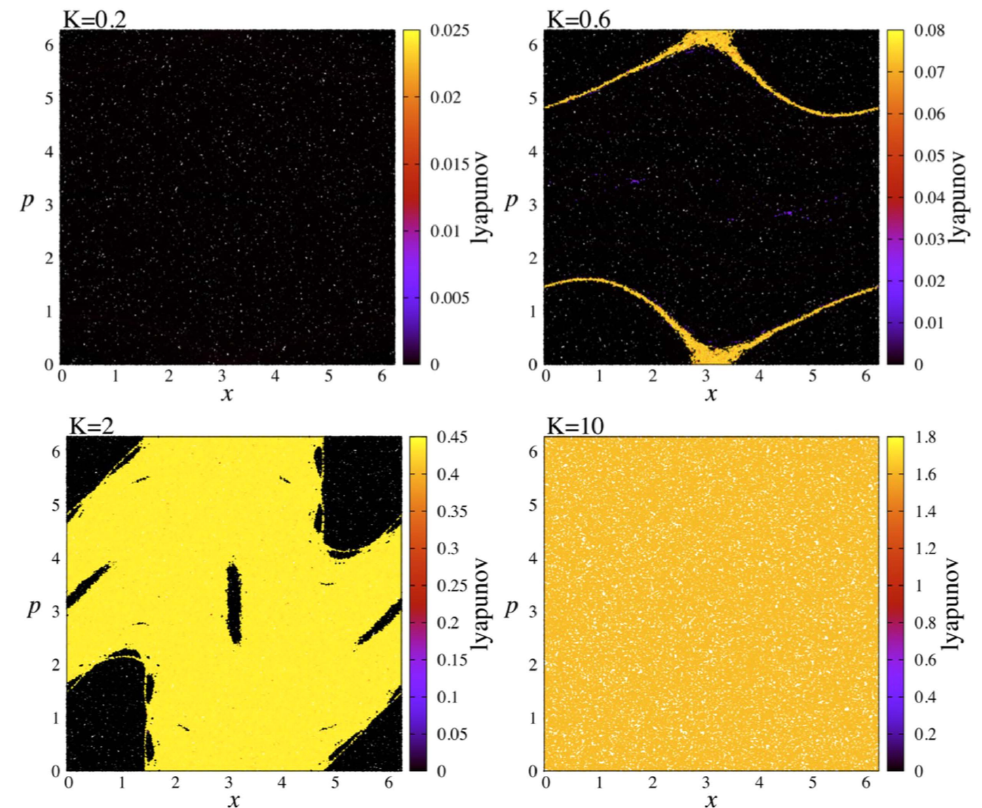
Figure 9. Lyapunov exponent results of the phase portrait of the standard map. The same repre- sentative K values are used. For each case, Lyapunov exponents are calculated for 200,000 initial conditions. In the calculation, each initial condition is iterated 107 times. From [100].